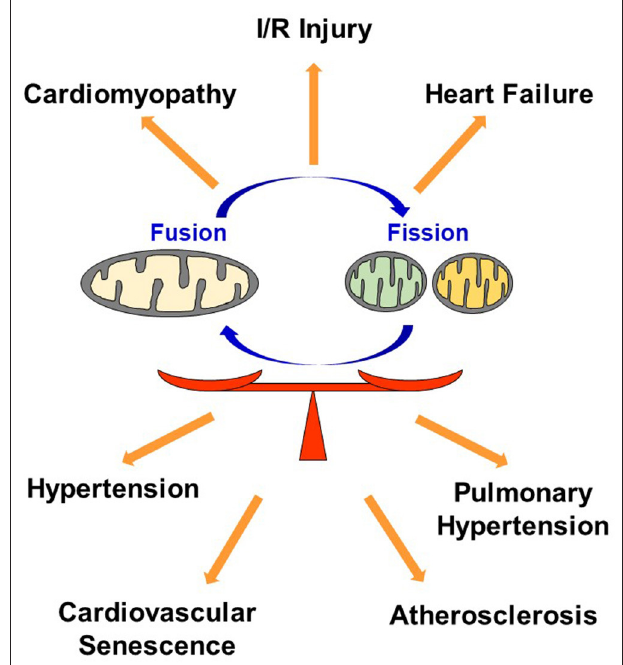
FIGURE 4 | Dysregulation in mitochondrial dynamics causes CVD. Maintaining optimal balance of mitochondrial fusion and fission plays a key role in regulating the quality of cardiovascular homeostasis. I/R, Ischemia